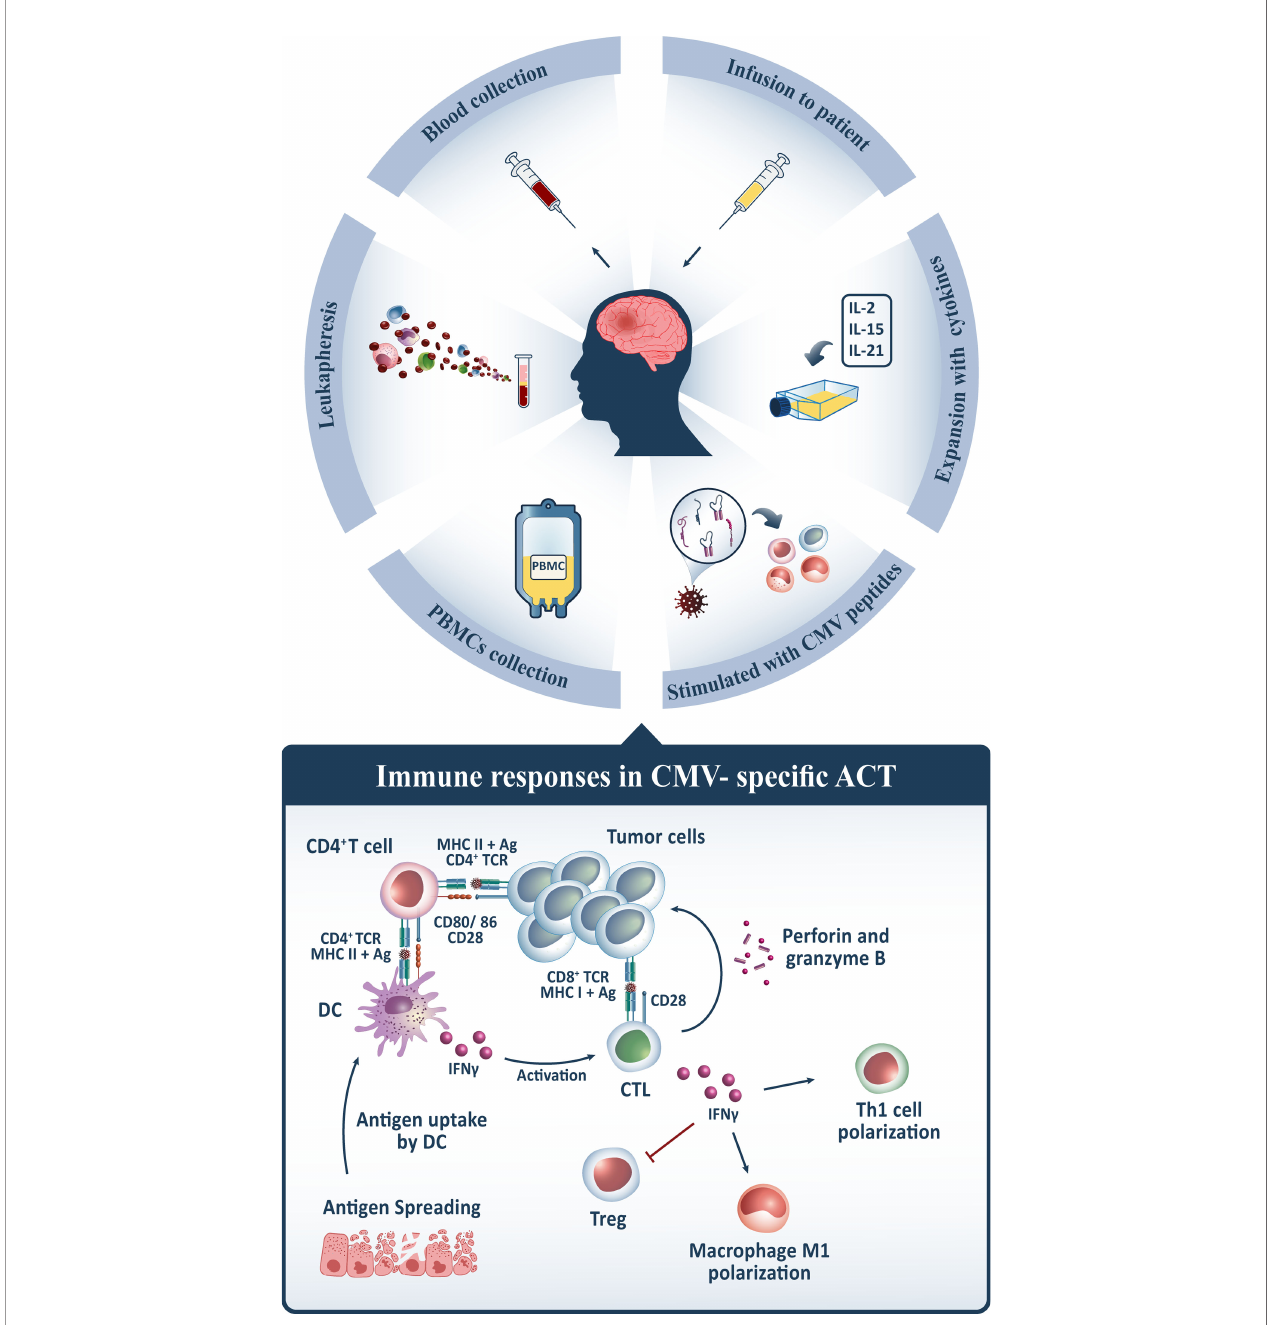
FIGURE 2 | For CMV-speci fi c ACT, PBMCs from GB patients ’ peripheral blood are harvested, stimulated with CMV peptides, expanded in vitro by conditioning with multiple cytokines such as IL-2/IL-15/IL-21, and afterward reinfused intravenously. Following administration, CMV-speci fi c CD8 + T cells traf fi c to tumor sites and recognize CMV antigens expressed on GB tumor cells, whilst interactions between CMV-speci fi c CD4 + T cells and dendritic cells (DC) maintain its activation via IFN- g release. CD8 + T cells release granzymes and perforin, which contribute to tumor cytolysis, and IFN- g , which indirectly provokes other immune cells to elicit the desired anti-tumor immune response. It induces tumoricidal M1 polarization in macrophages, T helper1 (Th1) polarization, and inhibits regulatory T cells (Tregs) in the tumor microenvironment, which is associated with immunosuppression. Upon tumor cytolysis, tumor antigens are released, which are taken up by DCs and presented to cytotoxic T lymphocytes (CTLs), activating them and triggering a multi-antigen directed anti-tumor